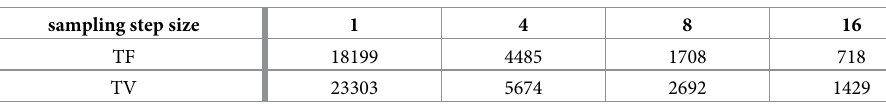
Table 2. TF and TV elapsed time in seconds.